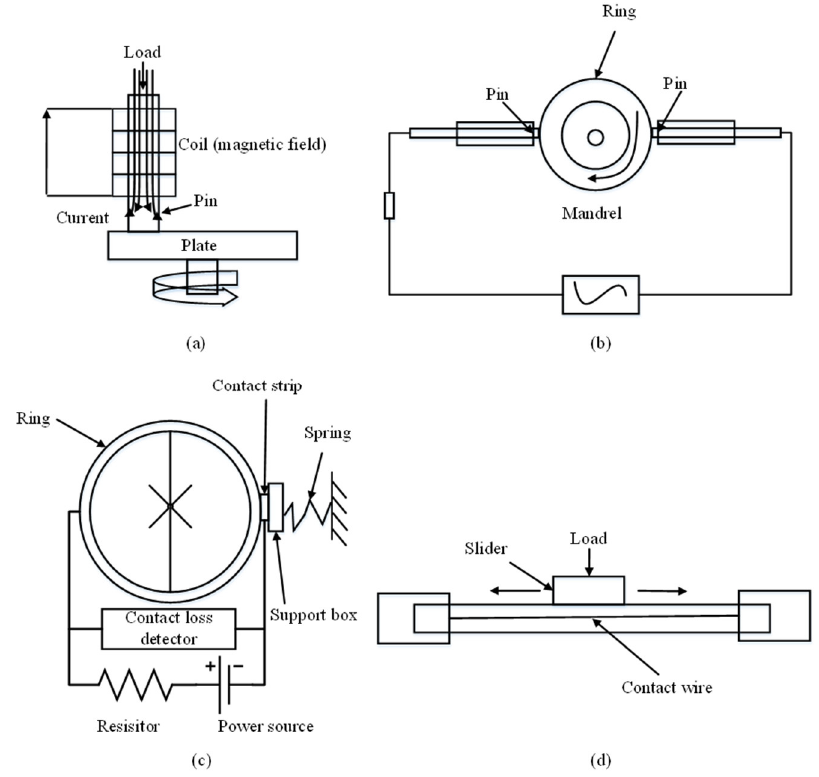
Figure 2. Four typical current-carrying friction and wear test devices [13–16]: ( a ) pin-disc type; ( b ) pin-ring type; ( c ) ring-block type; ( d ) line slider type. ( b ) pin-ring type; ( c ) ring-block type; ( d ) line slider